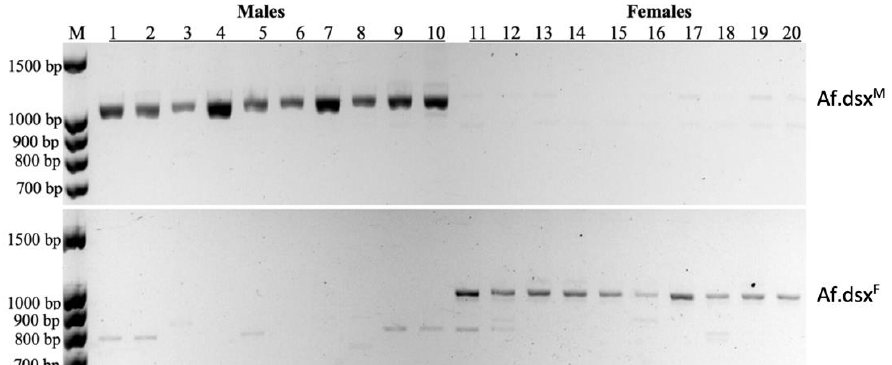
Figure 5. The presence of sex-specific transcript encoded by Af.dsx- 4 locus in A. franciscana . The sex-specific transcripts of Af.dsx F and Af.dsx F as determined by PCR from the cDNA samples of 20 juvenile animals individually. The amplification PCR products of Af.dsx M transcript could only be seen in the male individuals (lanes 1 to 10), while Af.dsx F transcript could only be found in female individuals (lanes 11 to 20). M: DNA marker.